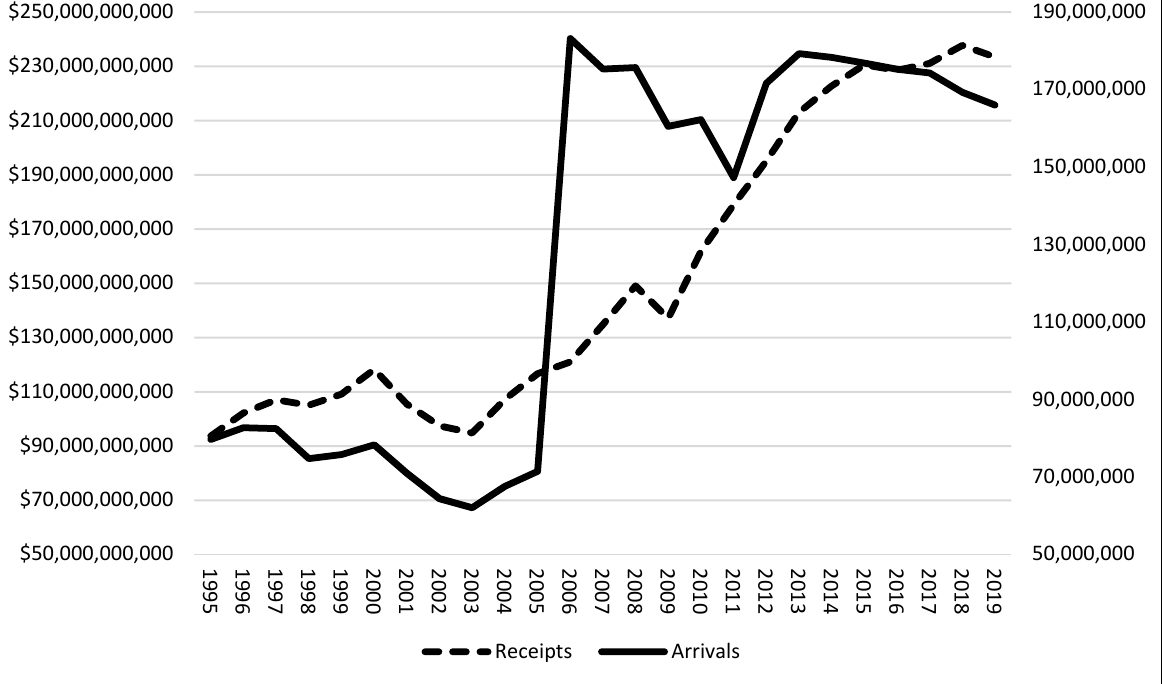
Figure 2. U.S. international tourism receipts and arrivals. Source: United Nations World Tourism Organization, Yearbook of Tourism Statistics.